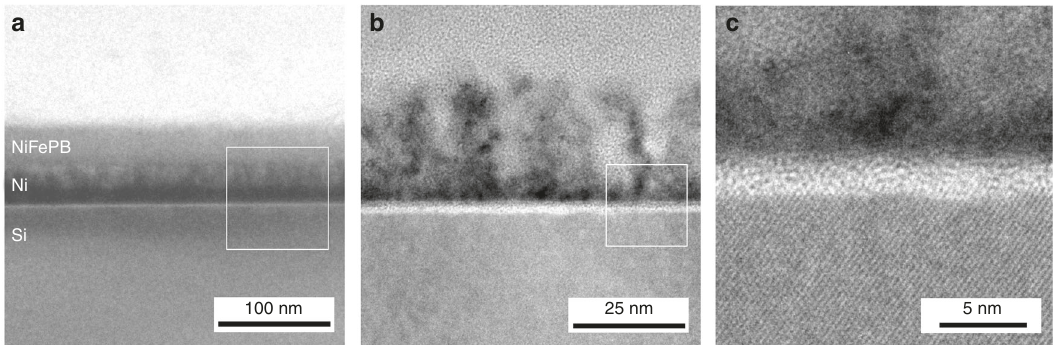
Fig. 2 Characterization of the Si/SiO x /Ni/NiFePB interface. Cross-sectional TEM images of p + -Si/SiO x /Ni/NiFePB- 75cy . The white square in a indicates the interface that is imaged in b and the white square in b indicates the interface that is imaged in